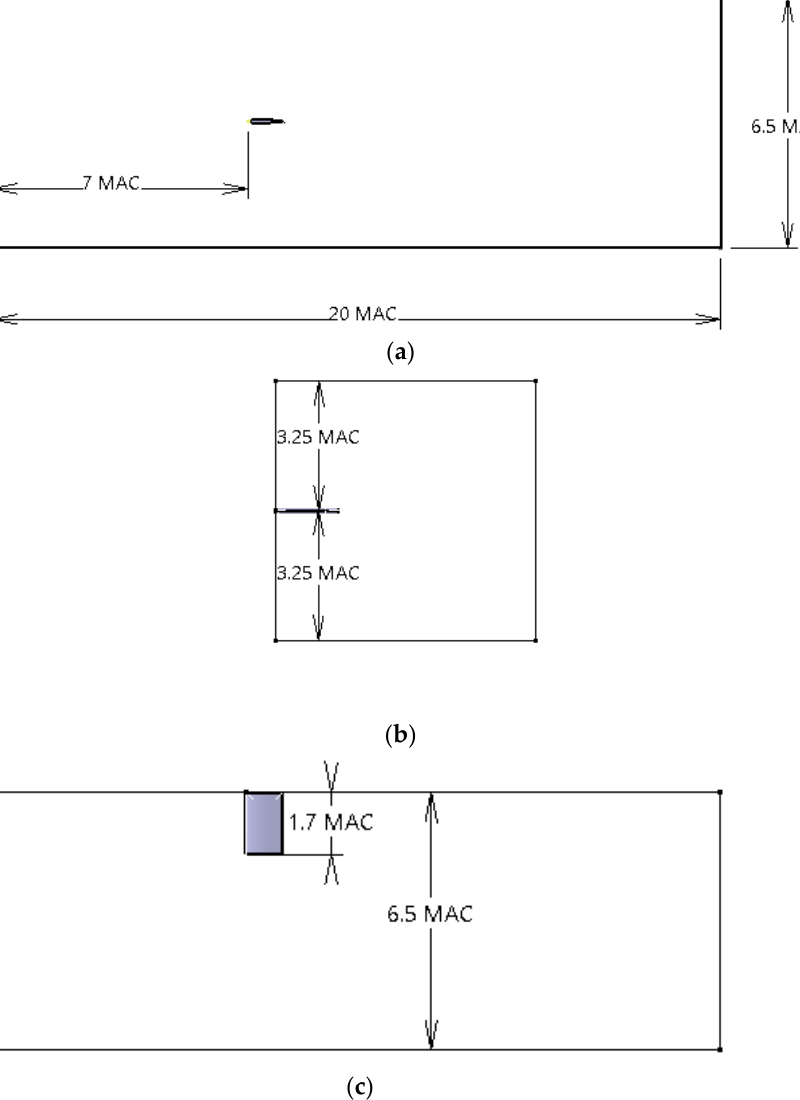
( b ) Figure 3. ( a ) Computational domain; ( b ) structured mesh around the wing. In order for the simulation to produce meaningful results, it was important to ensure that the geometry of the flow domain faithfully represents the experimental arrangement. Hence, for the analysis of this specific geometry, a type “H” computational domain was used. As shown in Figure 3b, the computational domain became more finite moving from the external surface of domain toward the surface of the wing section. The size of the first cell of the meshed domain over the wing section was equal to 1.96 × 10 − 5 m, in order to reach the boundary layer of the wing and to ensure that y + < 1. The computational domain consisted of a fully structured mesh grid, where the re- gion was divided into hexahedra, and it was constructed with the help of ICEM [9]. A mesh independence study of the number of elements constituting the computational do- main is one of the main stages of CFD analysis. In order to identify the minimum mesh density to ensure that the solution is independent of the mesh resolution, a mesh sensitiv- ity analysis was carried out in the construction and analysis of the CFD model. The vari- ation of drag and lift coefficient over the wing section at zero angle of attack is presented in the Figure 4. The mesh study indicated that a computational domain of 4,800,000 ele- ments for the original model and 1,350,000 elements for the downscaled model had accu- rate results.